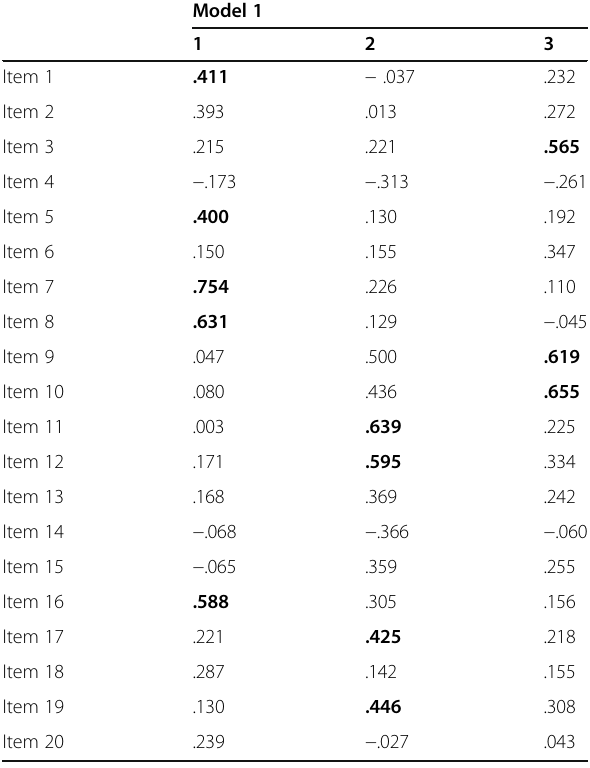
Table 2 Factor loading for 3-factor solution ( n